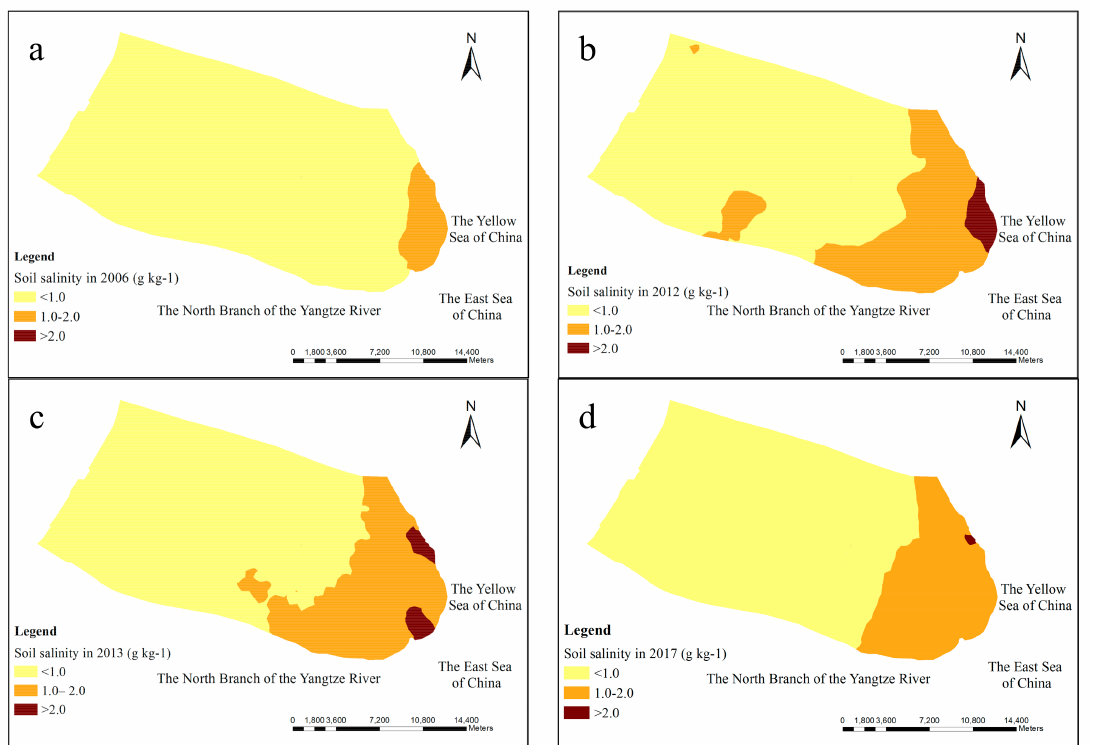
Figure 3. Survey region and distribution of soil sampling points (The black dots represented the sampling points). Figure 8. Spatial distributions of soil salinity in typical hydrological years. ( a ) Spatial distributions of soil salinity in 2006; ( b ) Spatial distributions of soil salinity in 2012; ( c ) Spatial distributions of soil salinity in 2013; ( d ) Spatial distributions of soil salinity in 2017.